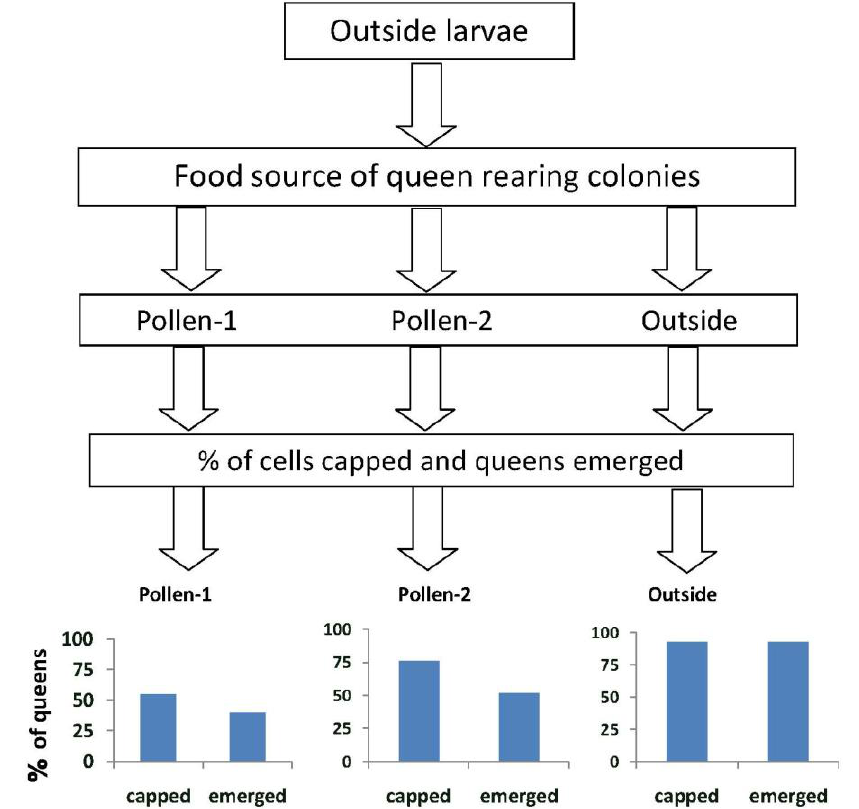
Figure 2. The percentages of queen cells that were capped and queens that emerged when (cid:79)(cid:68)(cid:85)(cid:89)(cid:68)(cid:72)(cid:3)(cid:73)(cid:85)(cid:82)(cid:80)(cid:3)(cid:82)(cid:83)(cid:72)(cid:81)(cid:3)(cid:73)(cid:82)(cid:85)(cid:68)(cid:74)(cid:76)(cid:81)(cid:74)(cid:3)(cid:11)(cid:179)(cid:82)(cid:88)(cid:87)(cid:86)(cid:76)(cid:71)(cid:72)(cid:180) ) colonies were reared as queens in outside colonies or in hives in an enclosed flight area that were fed pollen with chlorpyrifos alone (pollen-1) or with added Pristine ® fungicide (pollen-2). Percentages of capped queen cells and emerged queens in outside colonies were significantly higher than when the larvae were reared as queens in colonies fed pollen-1 (55% survival to capped stage; X 2 = 12.3, p < 0.0001 and 40% emergence; X 2 = 21.0, p (cid:148)(cid:3) (cid:19)(cid:17)(cid:19)(cid:19)(cid:19)(cid:20)(cid:3) (cid:12)(cid:3) (cid:82)(cid:85)(cid:3) (cid:83)(cid:82)(cid:79)(cid:79)(cid:72)(cid:81) -2 (76% survival to capped stage X 2 = 4.03, p = 0.046; and 51.8% emergence X 2 = 13.1, p < 0.0001). The percentage of larvae from outside colonies that survived to the capped brood stage in colonies fed pollen-2 was greater than in pollen-1 (76% and 55% respectively; X 2 = 4.55, p = 0.03). The percentages that emerged as queens however, did not differ (pollen-1 = 40%, pollen-2 = 51.8%; X 2 = 1.29, p =